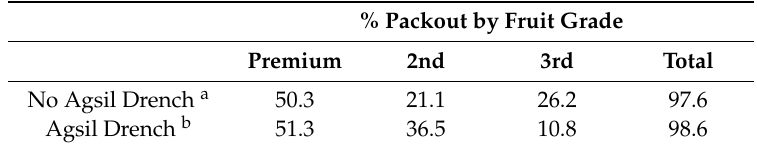
Table 2. Packout data collected May 2015 from Agsil amendment trial—Site 1, Childers. % Packout by Fruit